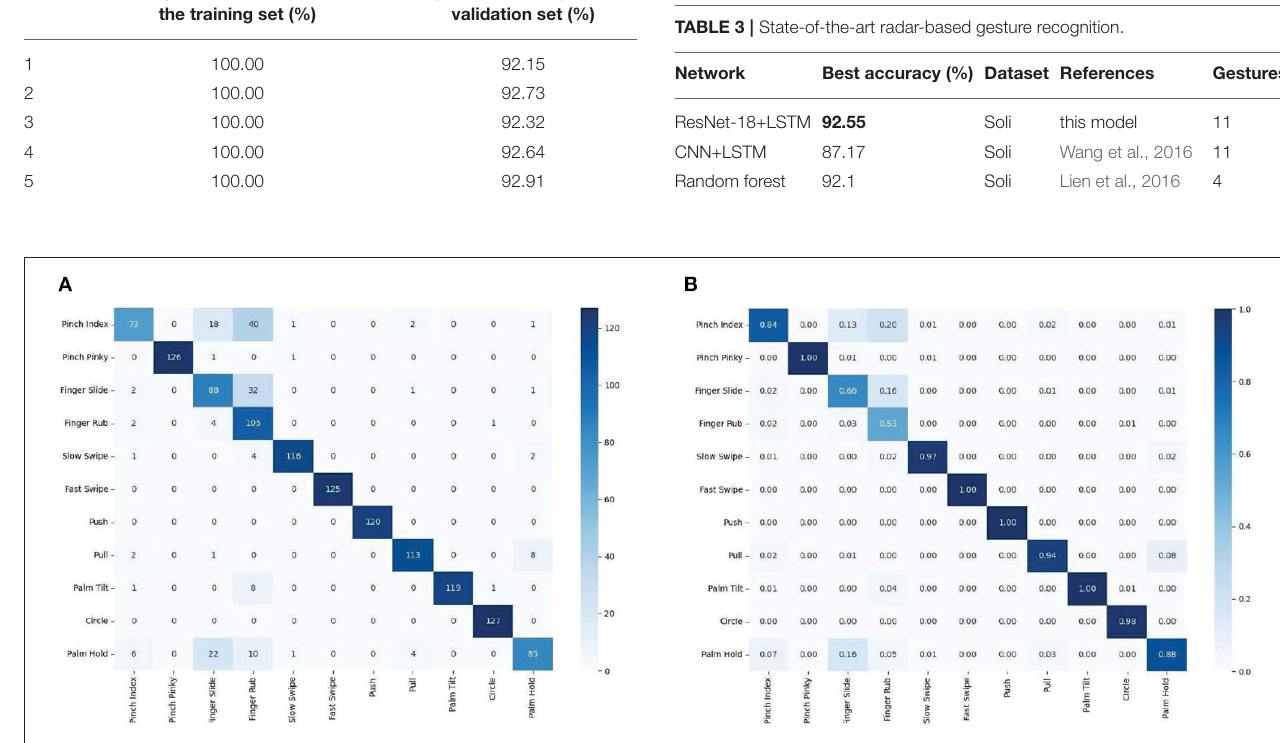
FIGURE 7 | Confusion matrix for the Soli 60–40% split for training and evaluation. (A) Confusion matrix for 11 categories of gestures of 10 users, (B) Normalized to percentage confusion matrix for 11 categories of gestures of 10 users.